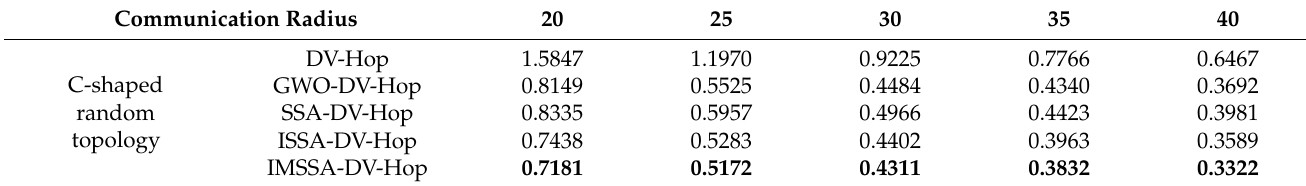
Table 2. Localization error in di ff erent communication radius in square random topology. Table 3. Localization error in different communication radius in C-shaped random